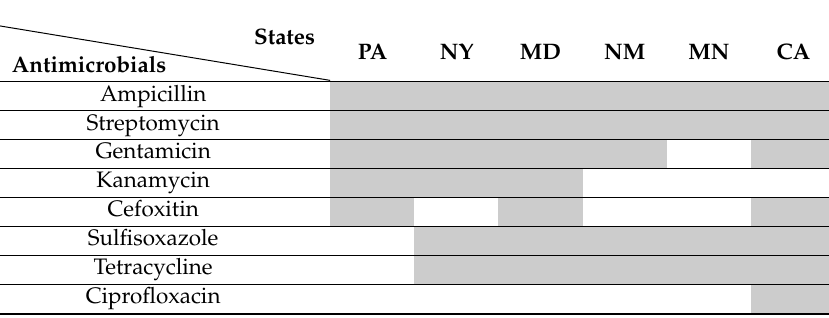
Note: the shaded areas indicate the resistance of antimicrobials in the corresponding